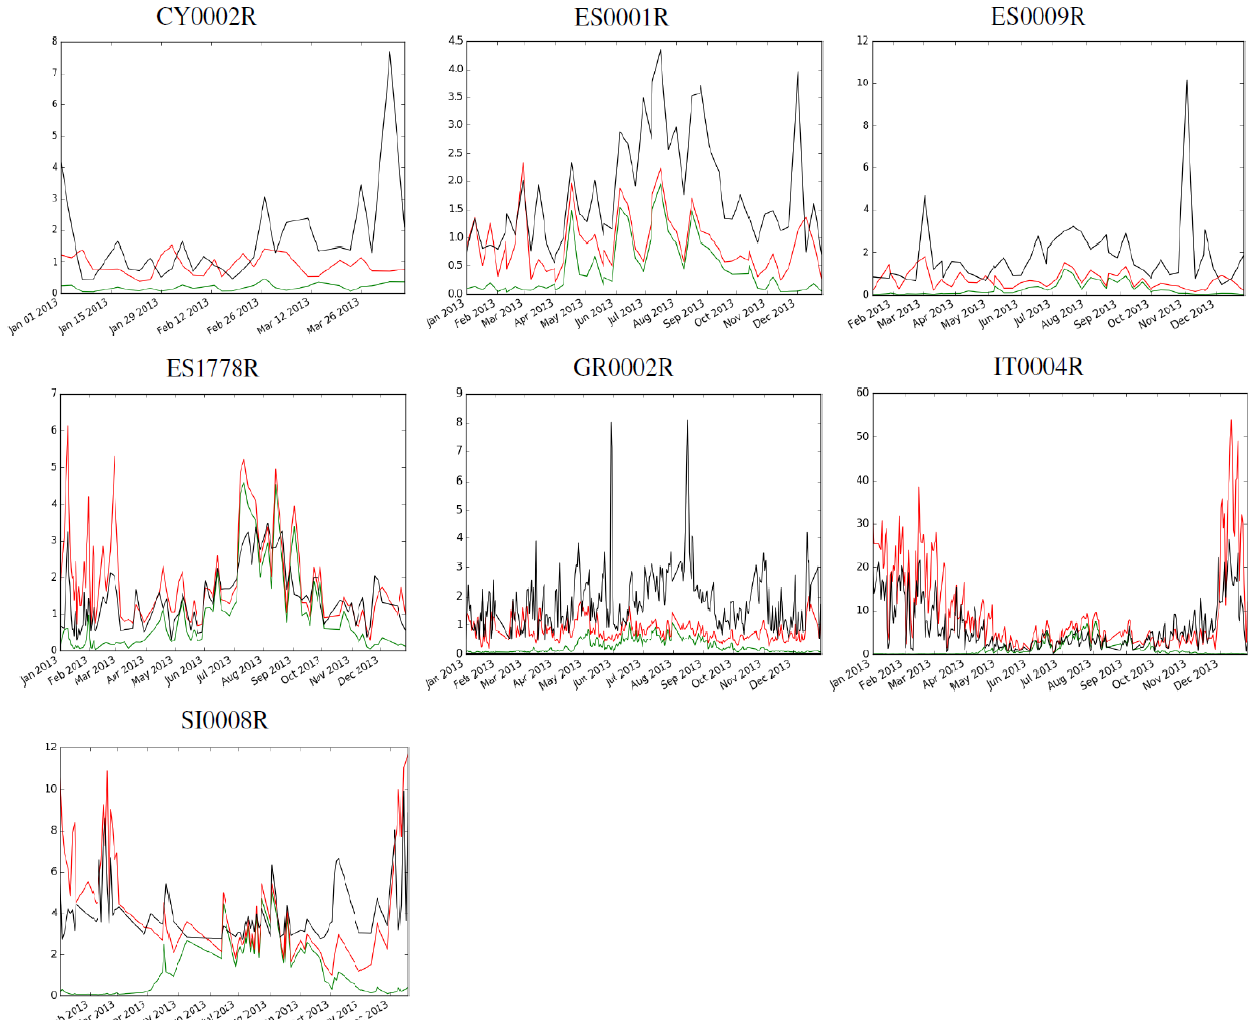
Figure 9. Temporal evolution of modeled (red line) and measured (black line) OC concentrations (in µgm − 3 ) for stations in the south of Europe. The green line corresponds to OC from biogenic